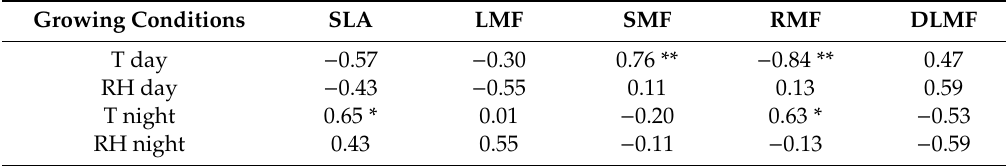
Table 4. Pearson correlation coe ffi cients for correlations between day and night growing conditions and SLA and organ mass fractions, respectively, including mean values of all 11 treatments ( n = 11). Growing Conditions SLA LMF SMF RMF DLMF T day − 0.57 − 0.30 0.76 ** − 0.84 ** 0.47 RH day − 0.43 − 0.55 0.11 0.13 0.59 T night 0.65 * 0.01 − 0.20 0.63 * − 0.53 RH night 0.43 0.55 − 0.11 − 0.13 − 0.59 **, *: significant at p < 0.01, < 0.05, respectively. The stem mass fraction was positively correlated with day temperature ( r = 0.76; p = 0.006) and the root mass fraction was negatively correlated with day temperature ( r = − 0.84; p = 0.001) and positively with night temperature ( r = 0.63; p = 0.037). Leaf and dead leaf mass fractions were not correlated with any of the